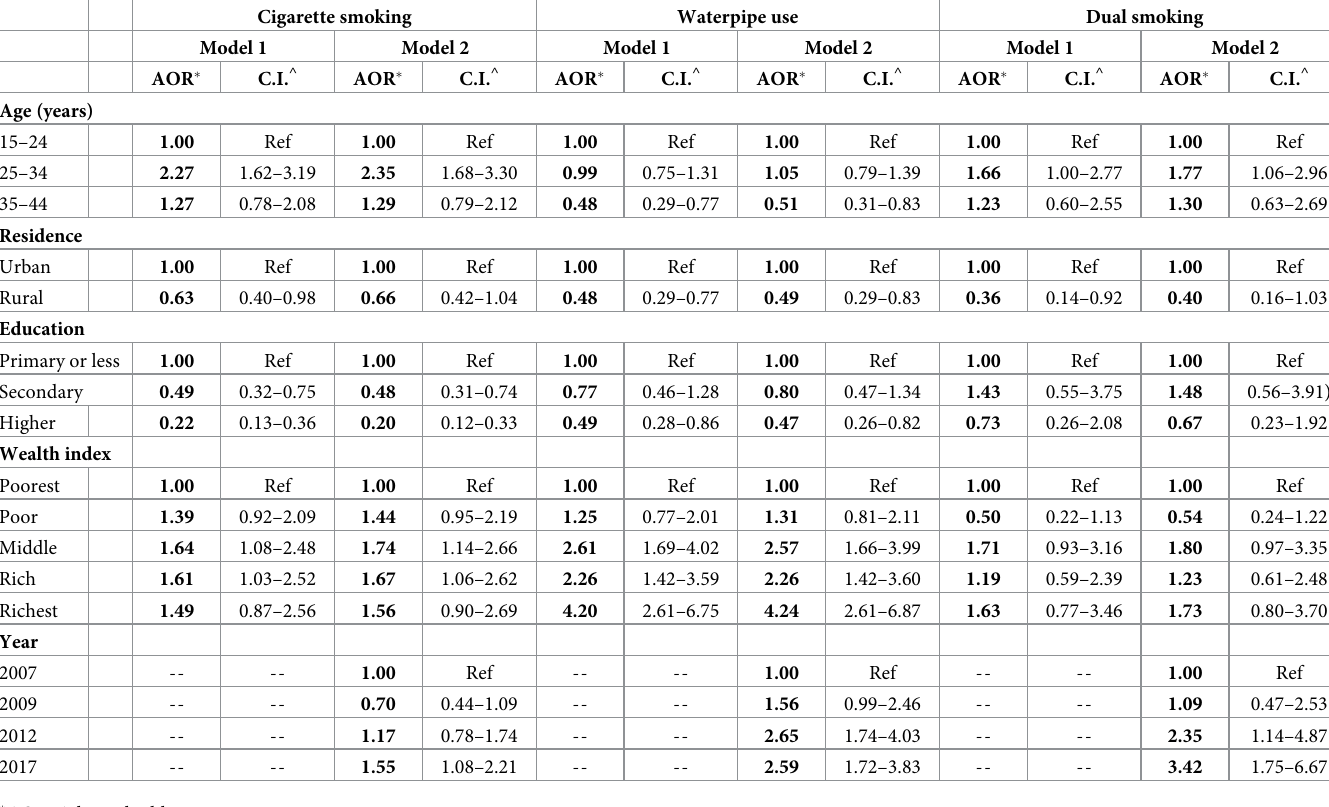
Table 5. Time-unadjusted (Model 1) and time-adjusted (Model 2) predictors of cigarette, waterpipe, and dual smoking among pregnant women in